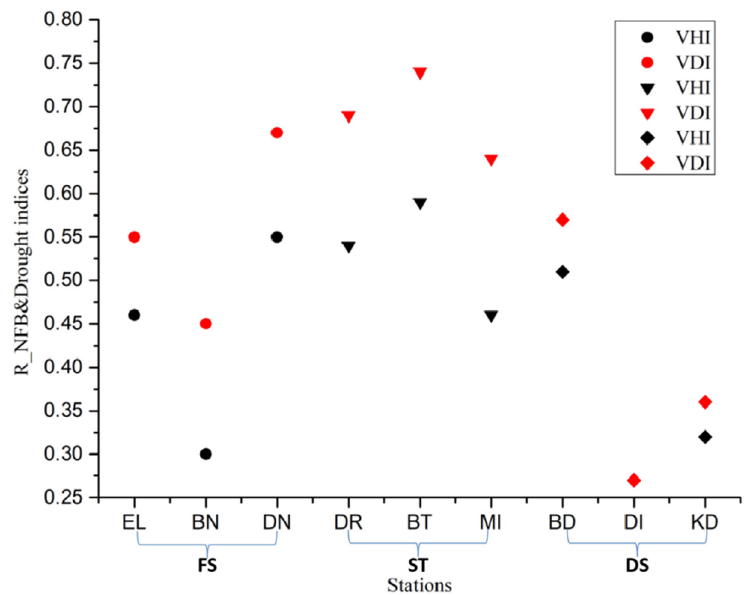
Figure 11. The R values for the VHI and VDI with the NFB (the results marked as dots are from forest steppe sites, triangles are from steppe sites, and diamonds are from desert steppe sites).